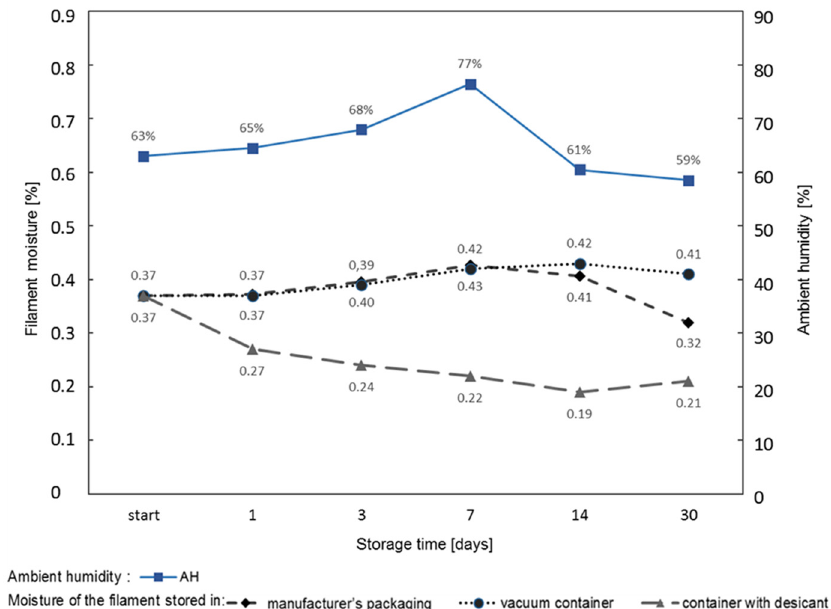
Figure 10. Changes in the moisture of the filament stored in various environments.